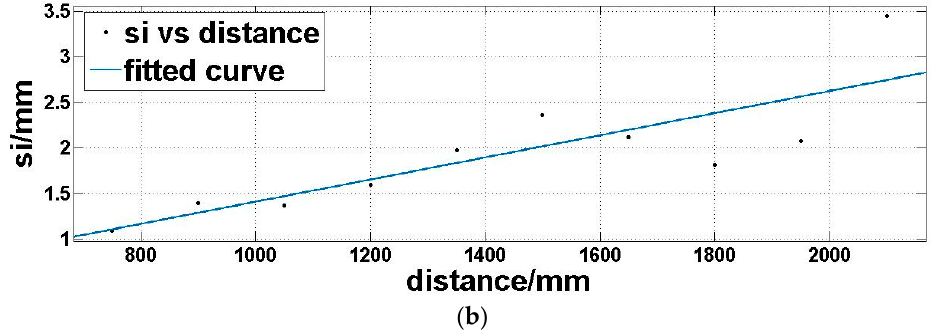
Figure 8. Expectation ( a ) and standard deviation ( b ) of offset matrix M oi under the same reflectivity and different distances. Table 4. Expectation and standard deviation of correction and uncorrection at different